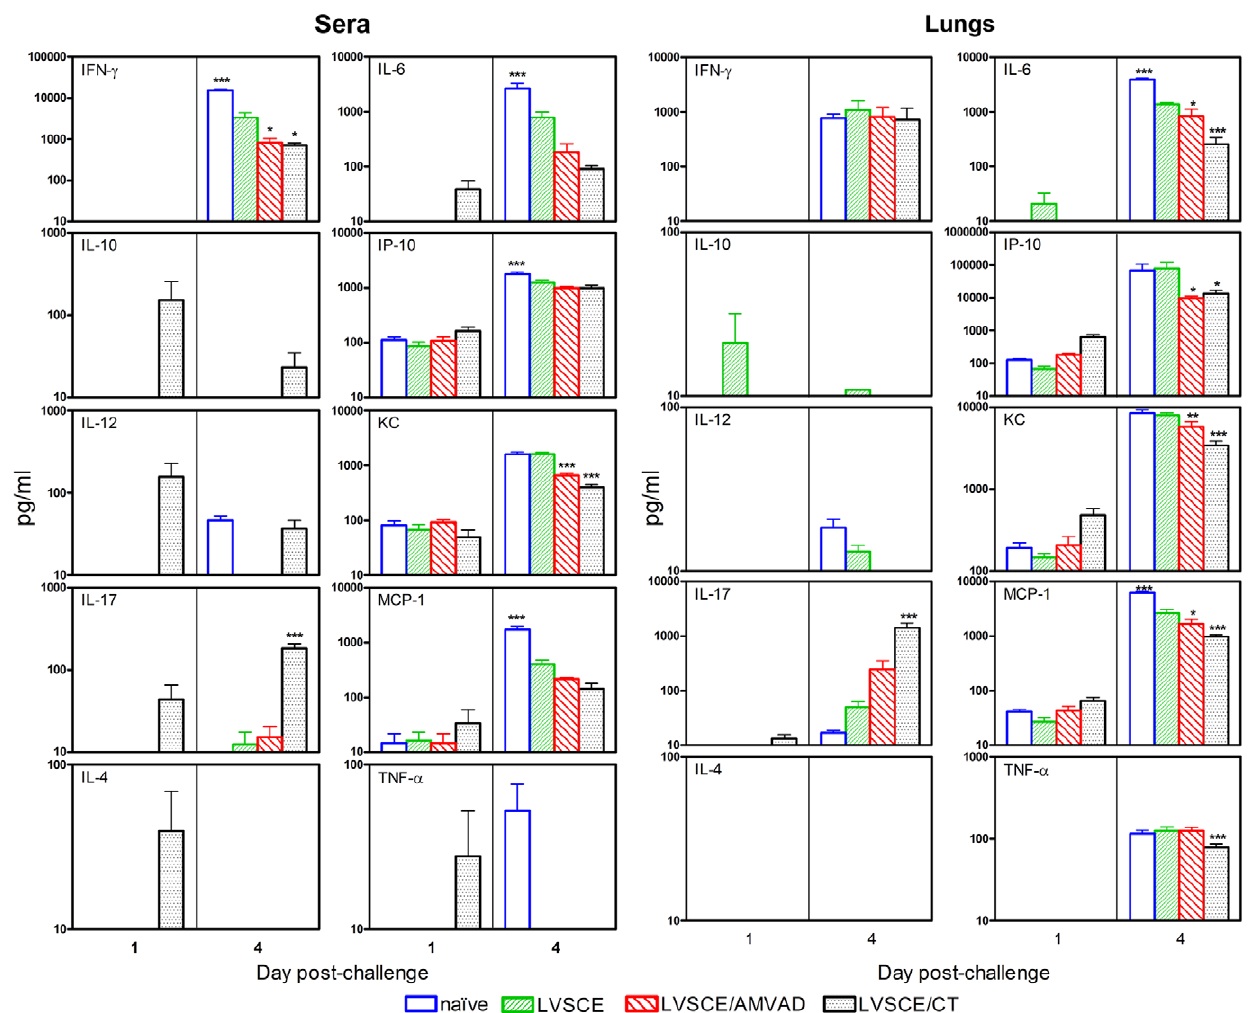
Figure 6. Changes in cytokine/chemokine levels in the sera (two left panels) and lungs (two right panels) subsequent to challenge. The sera and lung homogenates from naı¨ve, and LVSCE, LVSCE/AMVAD or LVSCE/CT immunized groups of mice intranasally challenged with F. tularensis LVS (3.4 6 10 4 cfu) and euthanized in Figure 5 experiment at 1 and 4 d post-challenge, were analyzed for the indicated cytokines/ chemokines. The data are presented as mean 6 SD for each group (n=5). The assay detection limit is 10 pg/ml. * p , 0.05, ** p , 0.01 and *** p , 0.001 vs. LVSCE alone immunized group.